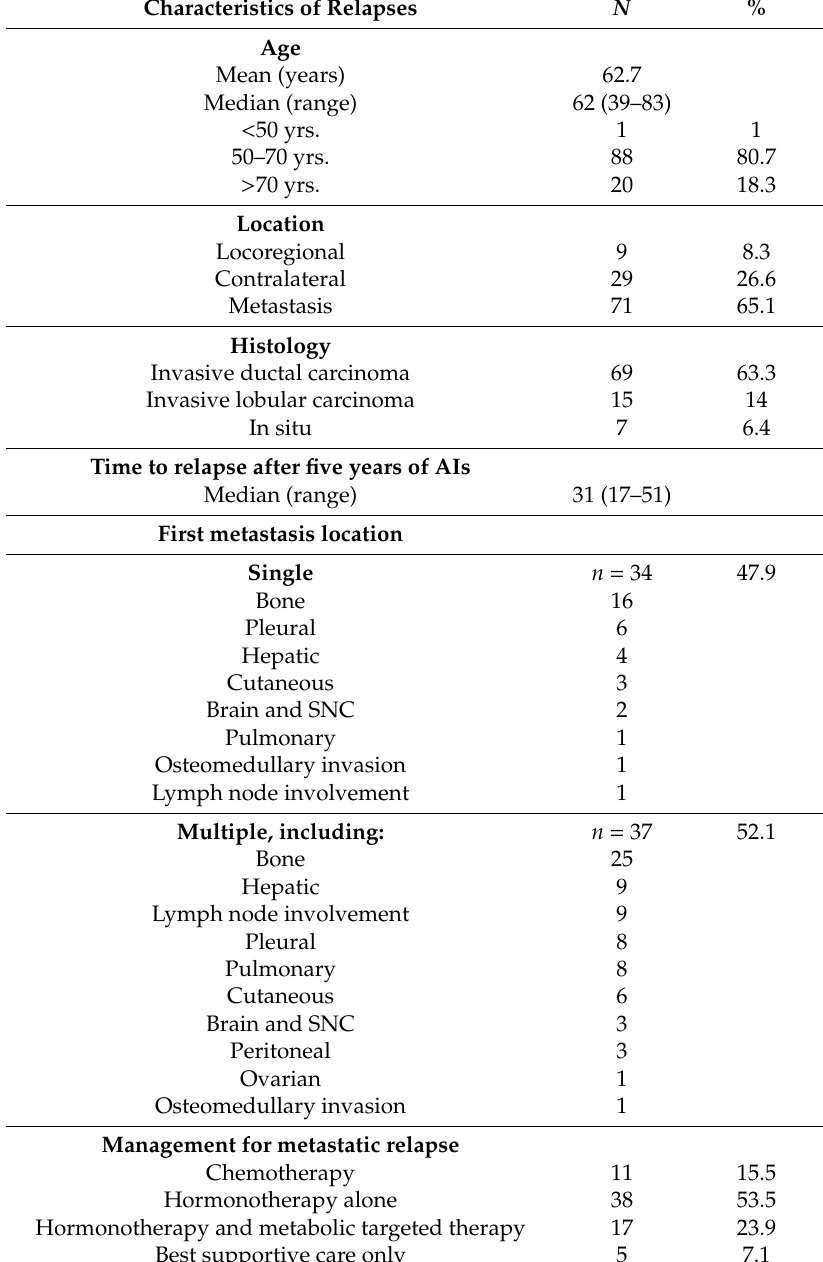
Table 2. Characteristics of relapsing patients ( n =